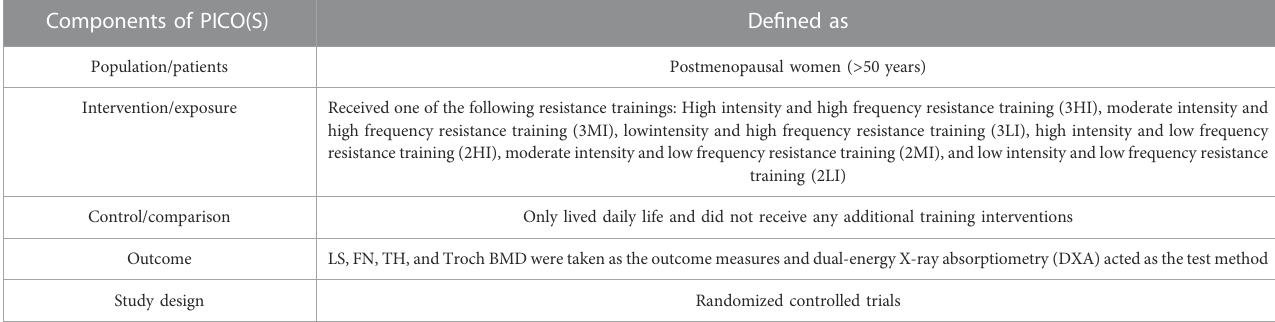
TABLE 1 Formulated question of the study based on PICO(S). Components of PICO(S) De fi ned as